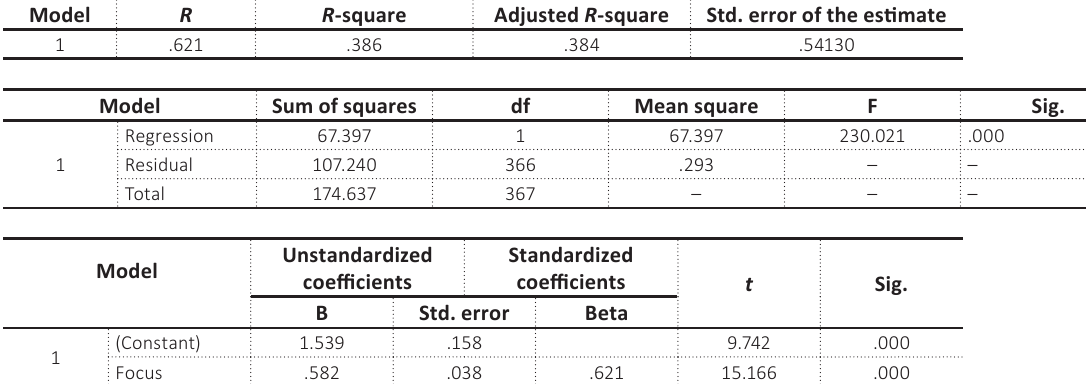
Table 4. Model summary, ANOVA and coefficients of 1 sub-hypothesis 1